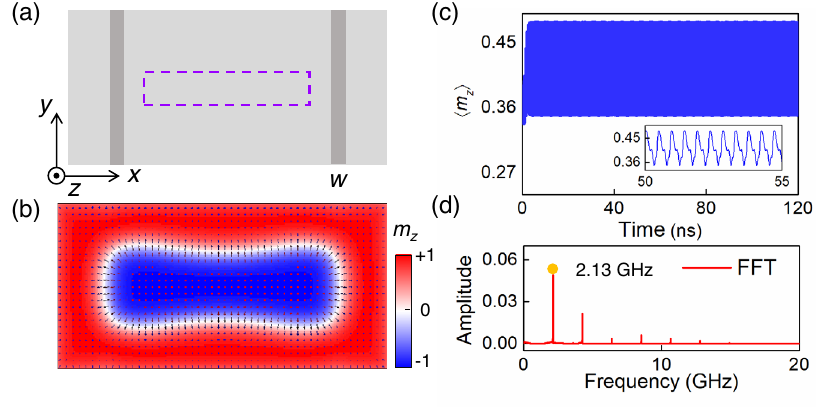
Fig. 1 Schematic diagram of an elongated-skyrmion-based oscillator and the response of magnetization to a spatially uniform direct current. a Schematic diagram of the ferromagnetic nanotrack utilized for stabilizing a pinned elongated skyrmion. w is the width of pinning sites. b The spin con fi guration of a relaxed elongated skyrmion, where colors represent the out-of-plane component of the local unit magnetization m z as indicated by the color bar. c Spatially averaged magnetization 〈 m z 〉 of the entire fi lm oscillates periodically when the driving current density is 6 MA cm − 2 . Inset shows the enlarged oscillations in 5.0 ns. d Frequency spectra of this oscillation is obtained from the fast Fourier transform (FFT) of 〈 m z 〉 in ( c